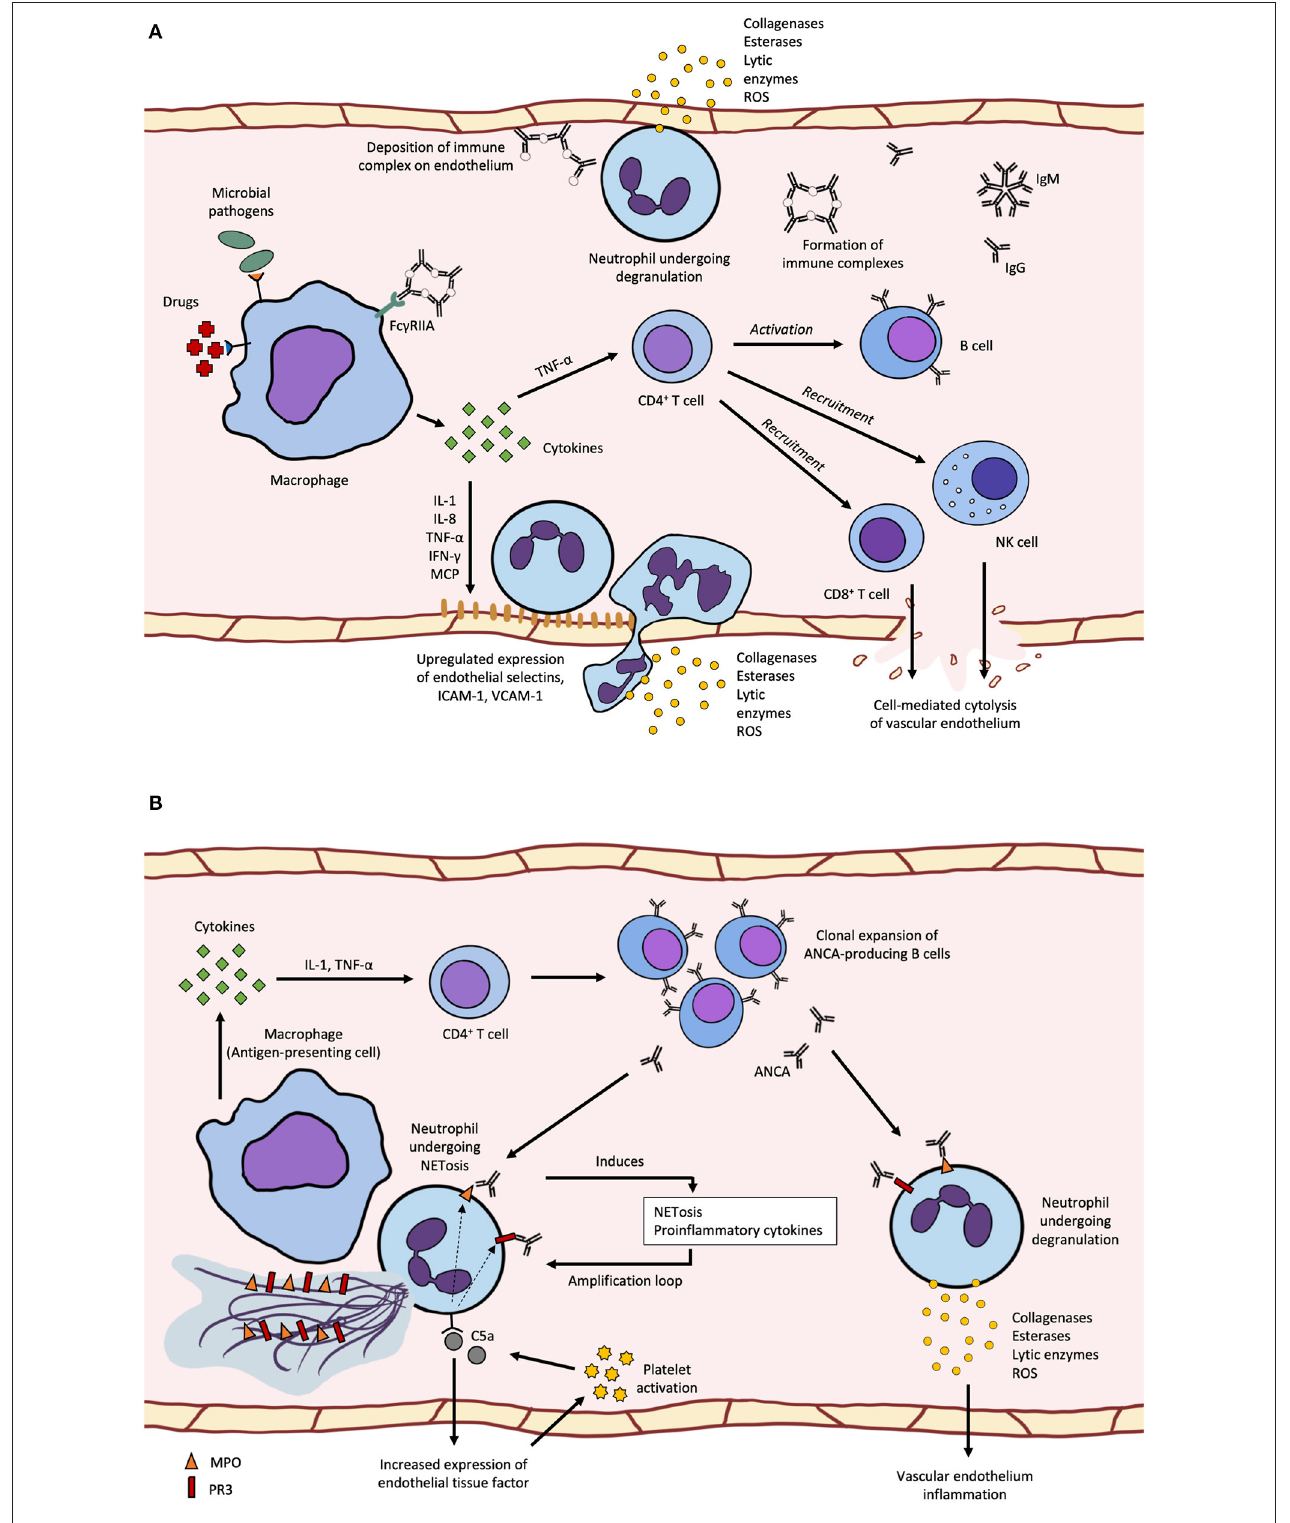
FIGURE 1 | (A) cutaneous small-vessel vasculitis (CSVV) begins with pre-exposure to microbial pathogens or certain drugs can induce pro-inflammatory cytokine secretion by macrophages leading to increased endothelial selectin, ICAM-1 and VCAM-1 expression, neutrophil diapedesis and degranulation that damages the vascular wall and surrounding tissues. Activation of the adaptive immune system leads to recruitment of cytotoxic lymphocytes and production of IgG and IgM